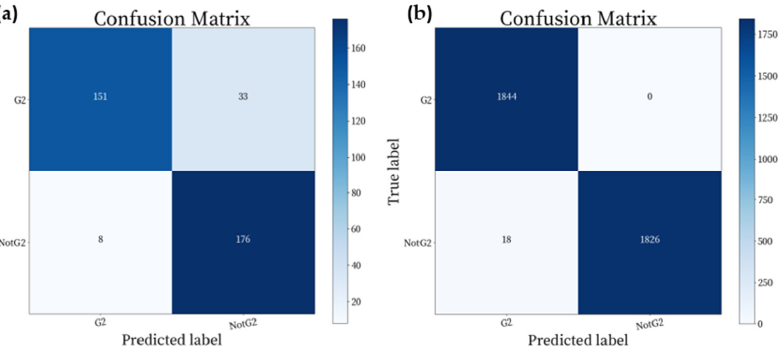
Figure 11. The confusion matrix of classification. ( a ) Two-class classification of original images; ( b ) two-class classification of generated images.